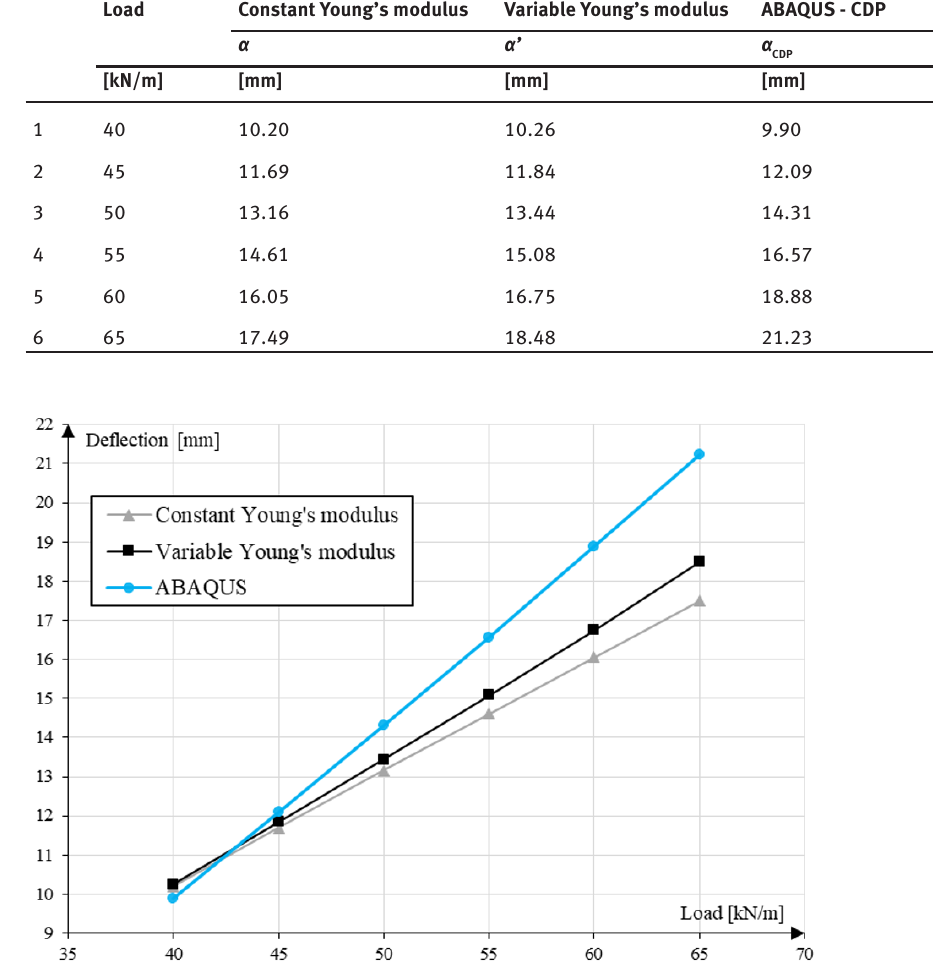
Figure 24: Maximum absolute deflection versus applied load for bar model taking into account constant and variable Young’s modulus and for ABAQUS FEM